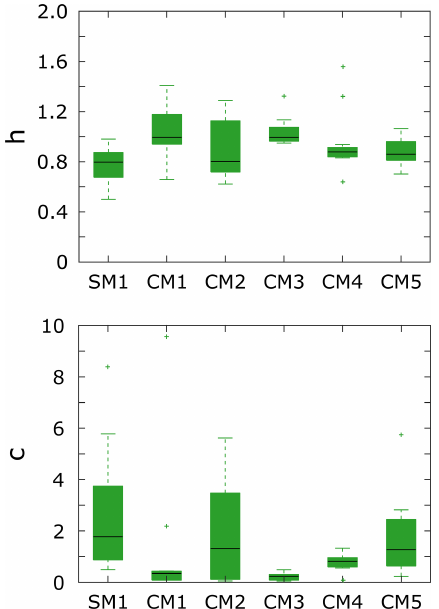
Figure 11. Value distributions for h and c for Hack’s law, as given in Eq. (13), in the models. The black lines indicate the median, while the bottom and top edges of the green box indicate the 25th and 75th percentiles, respectively. The green whiskers outside the box cover the data point at < 25th and > 75th percentiles that are not considered outliers, here indicated by green